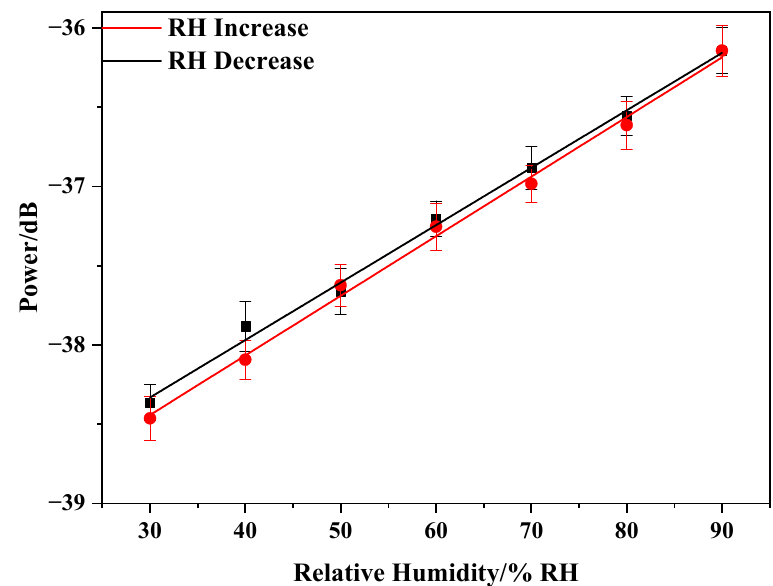
Figure 9. PVA nanofiber film humidity response fitting curve.